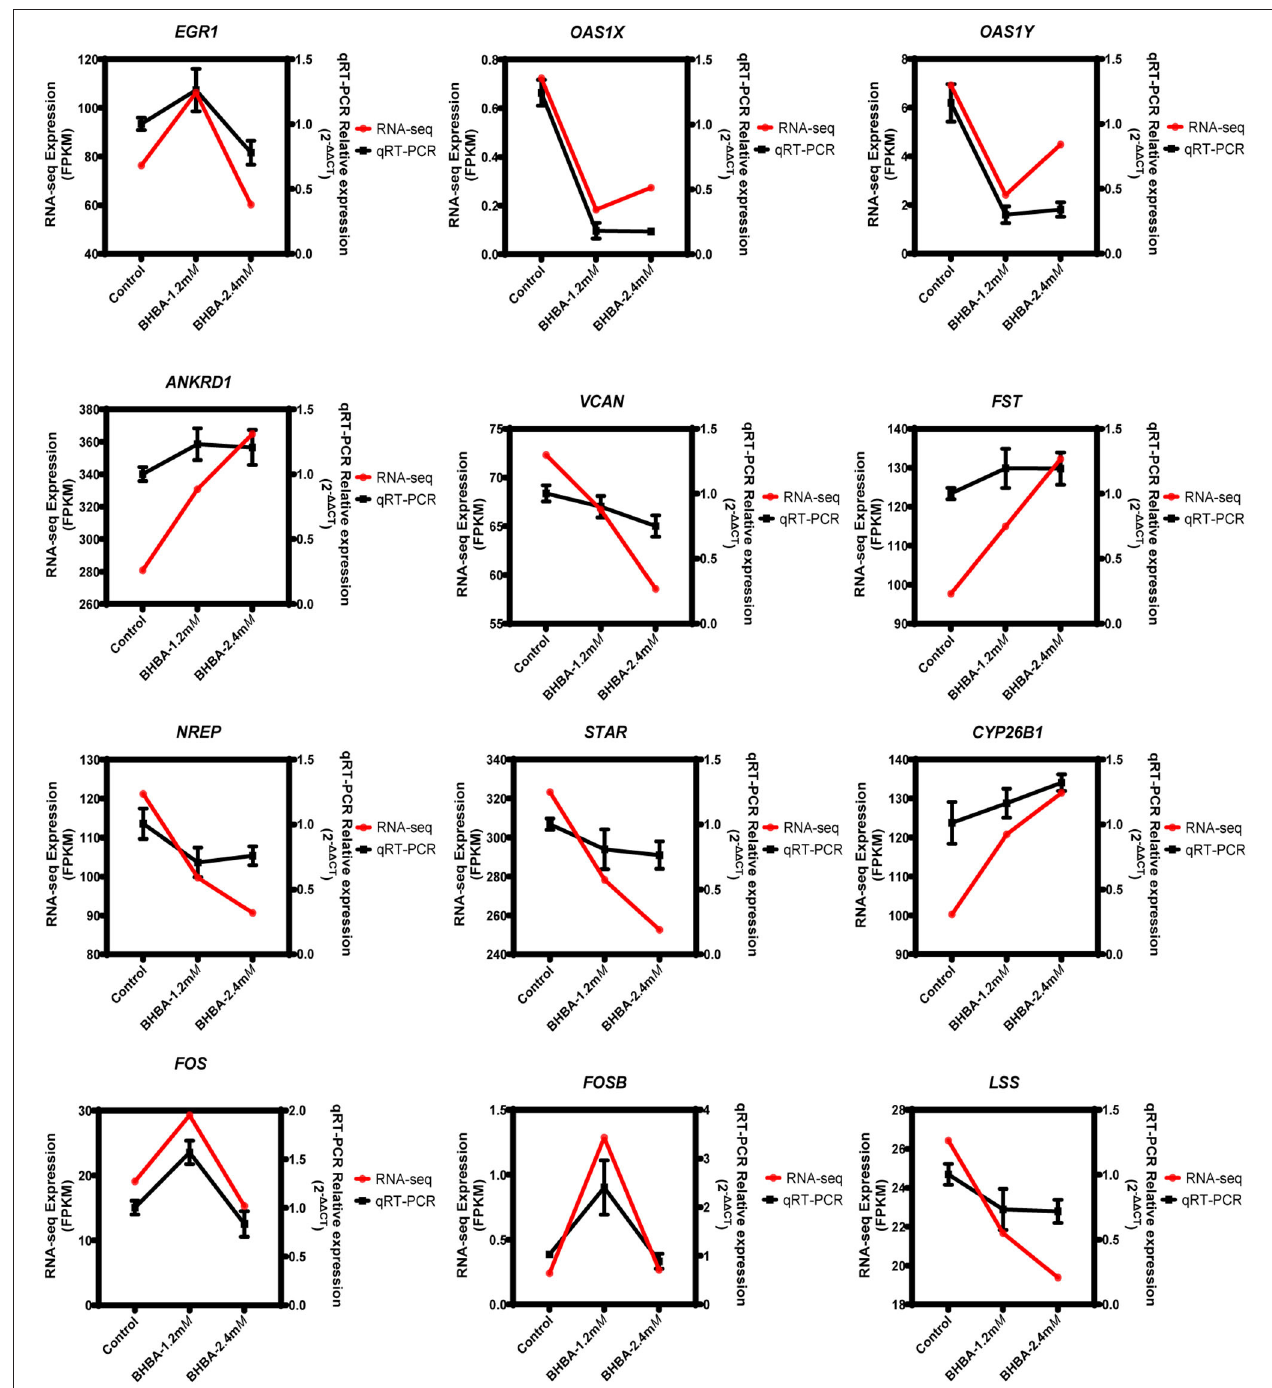
FIGURE 8 | Validation of the RNA-seq data by qRT-PCR.